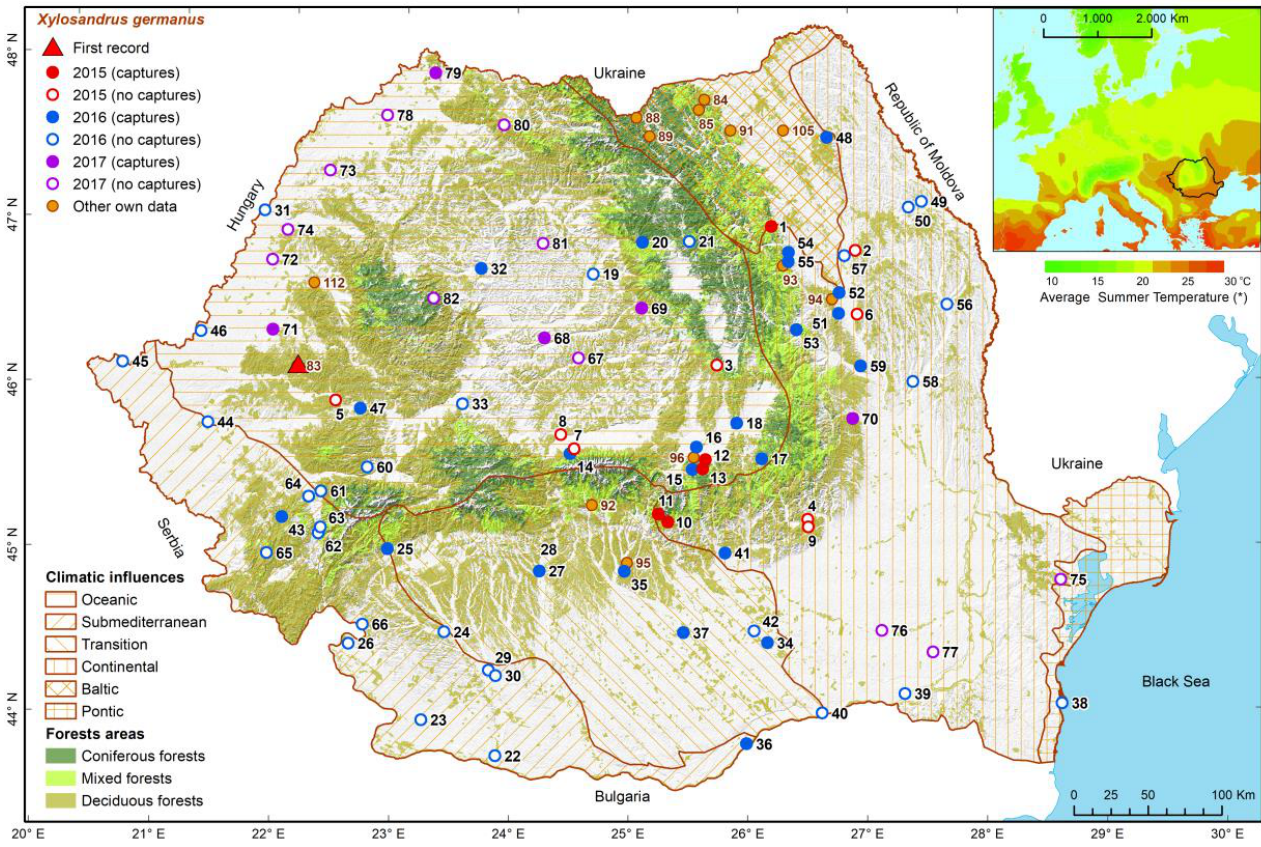
Figure 8. Geographic distribution of places where the BSB presence was detected between 2009 and 2017. (The correspondences between point numbers and names of locations are given in Table